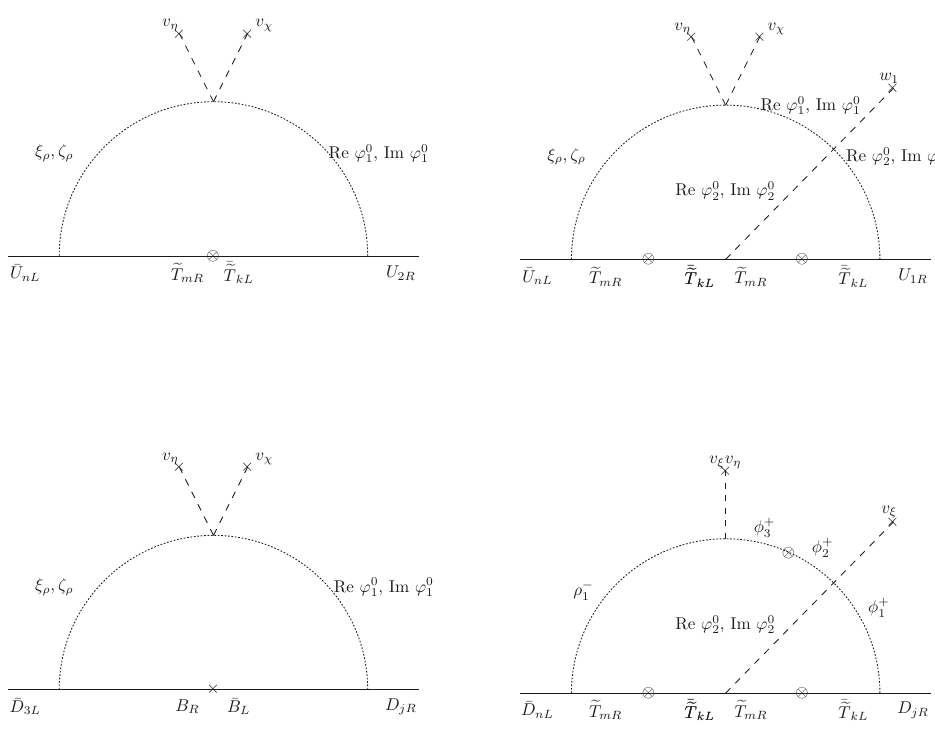
Figure 1 . Loop Feynman diagrams contributing to the entries of the SM quark mass matrices. Here m; n; k = 1 ; 2 and j = 1 ; 2 ; 3, whereas w 1 corresponds to the mass dimension coe(cid:14)cient of the trilinear scalar coupling (cid:3) . The cross marks to the symmetry preserving and softly breaking mass insertions,